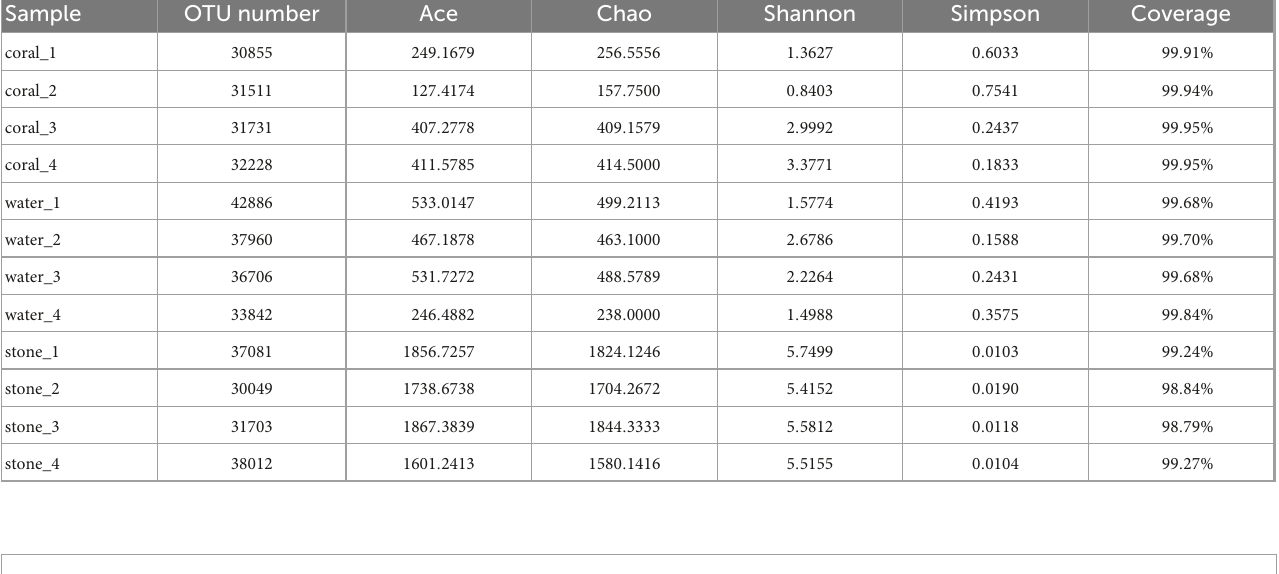
TABLE 2 Alpha diversity index analysis of symbiotic bacteria in the coral culture system.